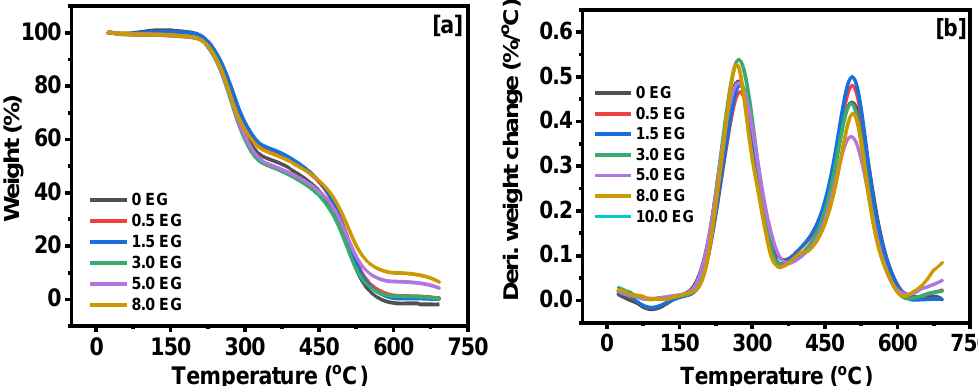
Figure 13. Thermogravimetric analysis ( a ) and derivative weight loss curves ( b ) of PU foams in a nitrogen environment.